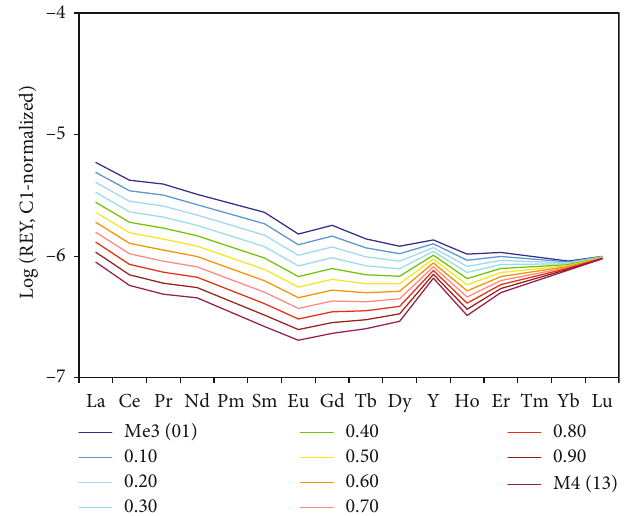
Figure 10: Mixing of basaltic and limestone groundwater showing the change in rare earth distribution